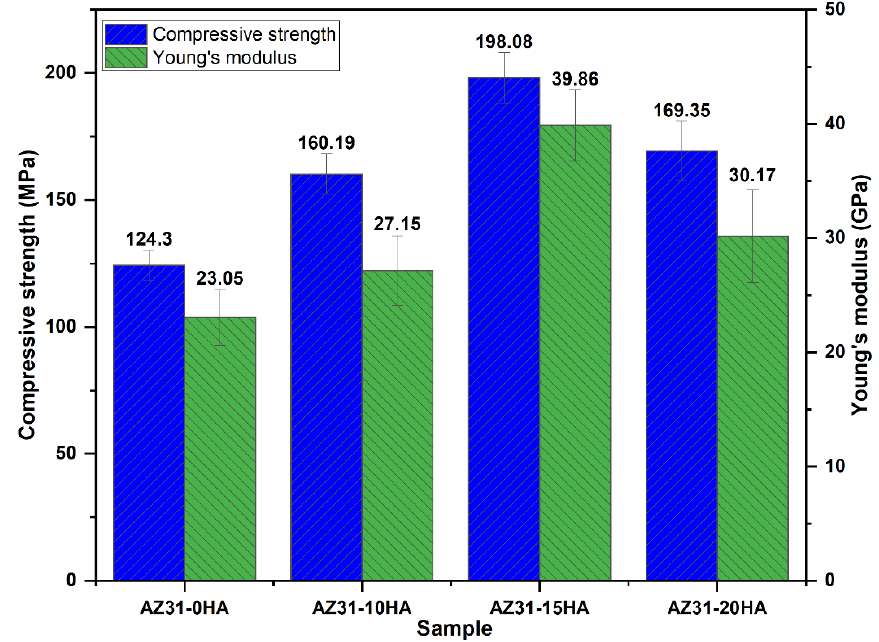
Figure 9. Compressive strength and Young ’ s modulus of microwave-sintered BMMCs.